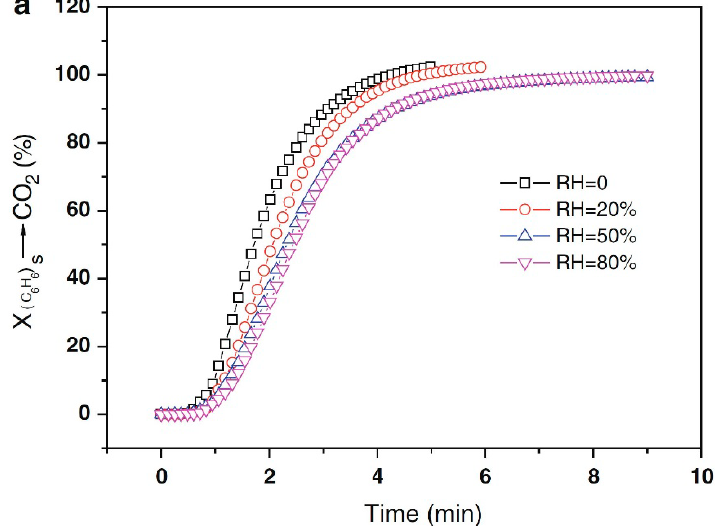
Figure 10. Effect of relative humidity (RH) on plasma catalytic oxidation of stored benzene over 0.8 wt.% Ag/HZ catalysts to CO 2 (storage stage: 4.7 ppm benzene, 0%–80% RH (25 °C), 600 mL/min flow rate of simulated air, t 1 = 1 h; discharge stage with 60 mL/min O 2 , P = 4.7 W. Reprinted from Ref. [42], with permission from